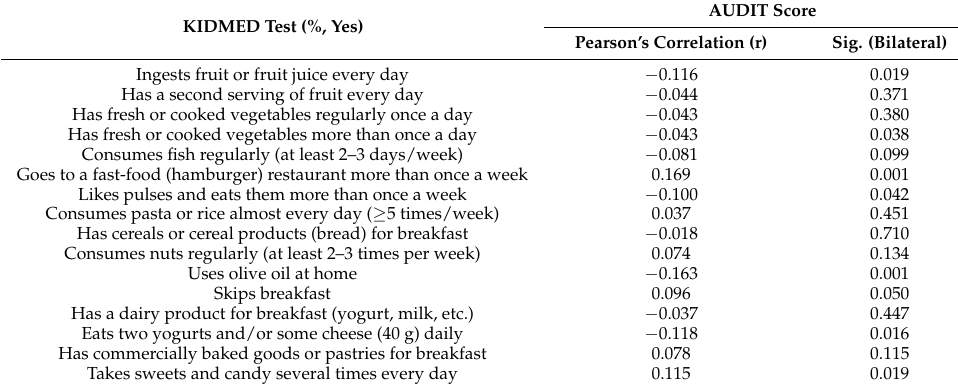
Table 2. Correlation between AUDIT score and responses for each item of the KIDMED score.